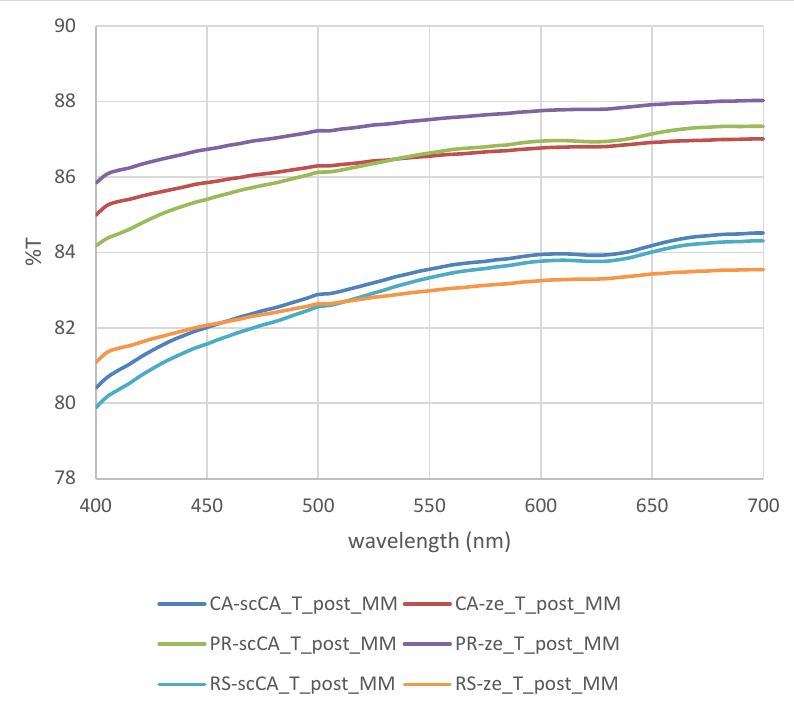
three printers compared.